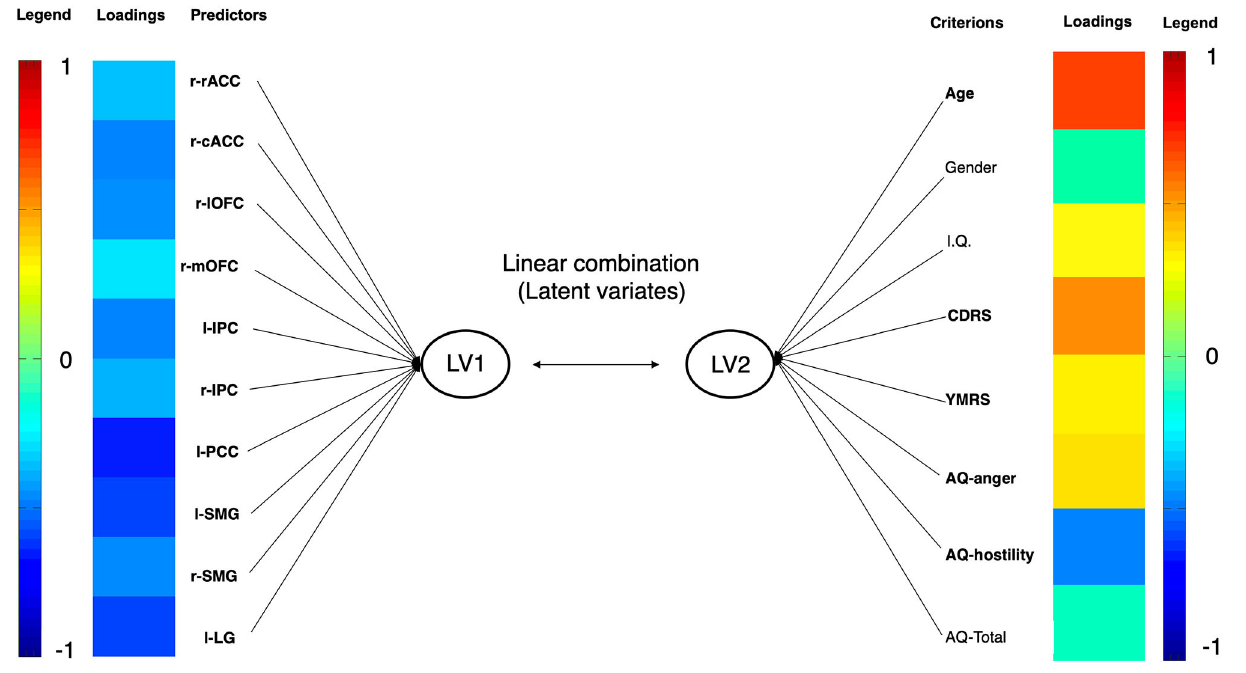
FIGURE 3 | Graphical representation of CCA in youth with PBD. Each variable’s loading strength is represented with a color. As the loading approaches the value of − 1, the loading color will approach the color deep blue. As the loading approaches the value of 1, the loading color will approach the color red. PBD, pediatric bipolar disorder. IPC, inferior parietal cortex; SMG, supramarginal gyrus; LG, lingual gyrus; lOFC, lateral orbitofrontal cortex; mOFC, medial orbitofrontal cortex; pACC, posterior anterior cingulate cortex; PCC, posterior cingulate cortex; rACC, rostral anterior cingulate cortex. LV, latent